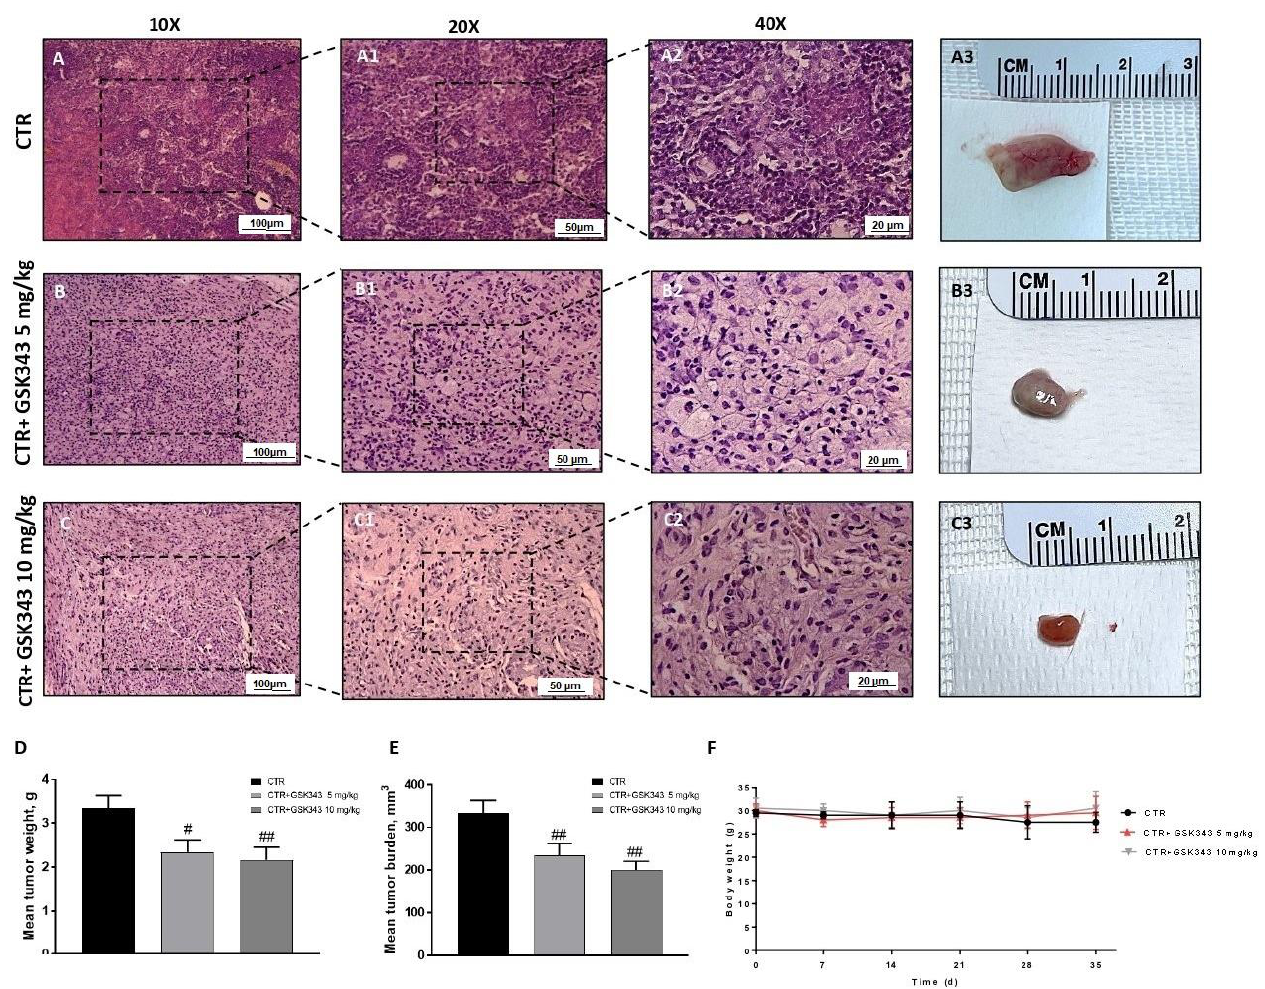
Figure 5. Effect of GSK343 treatment on tumor growth. Elevated nuclear pleomorphism was observed in the control group ( A , A1 , A2 ); however, GSK343 at doses of 5 mg/kg and 10 mg/kg significantly reduced it ( B , B1 , B2 , C , C1 , C2 ). The panels D and E showed a reduction in tumor weight and tumor burden, respectively, following GSK343 treatment at doses of 5 mg/kg and 10 mg/kg without encountering important weight differences ( F ). Sections were observed and photographed at 10 ×, 20× and 40× magnifications. Data are representative of at least three independent experiments. ( D ) # p < 0.05 vs. Ctr; ## p < 0.01 vs. Ctr; ( E ) ## p < 0.01 vs. Ctr.